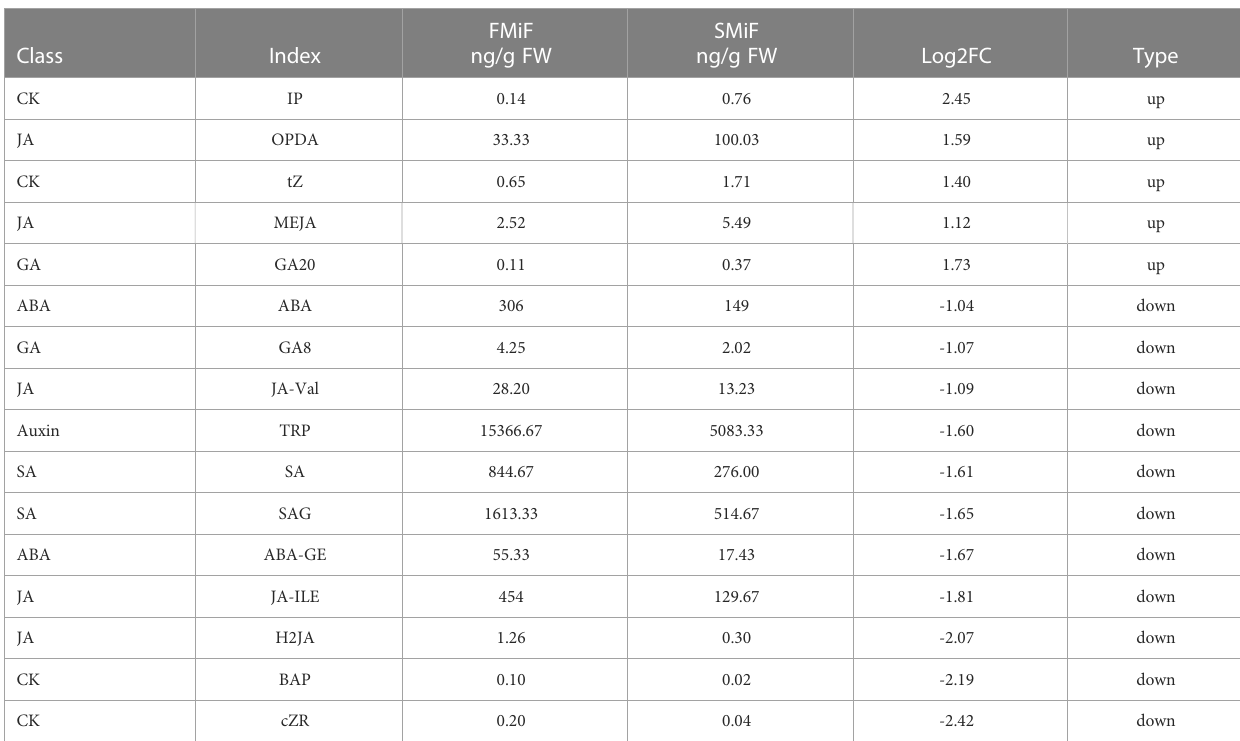
TABLE 1 Differences in hormone content in the comparison of FMiF_vs_SMiF.